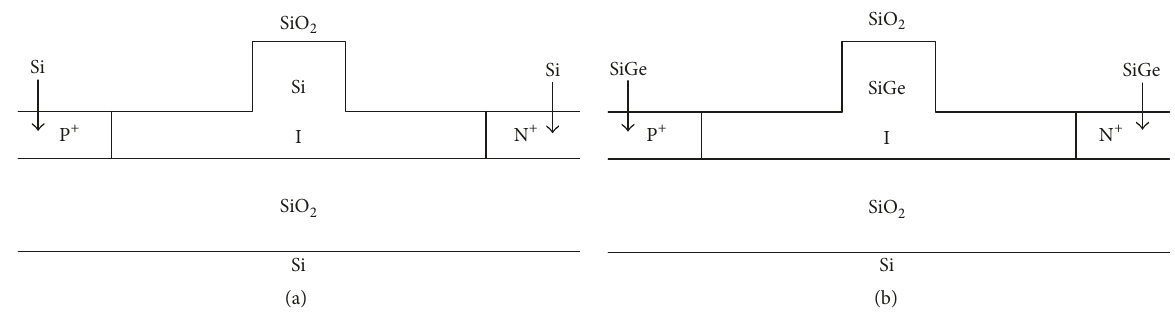
Figure 2: Two type modulation structures: (a) SOI structure and (b) SiGe-OI structure.